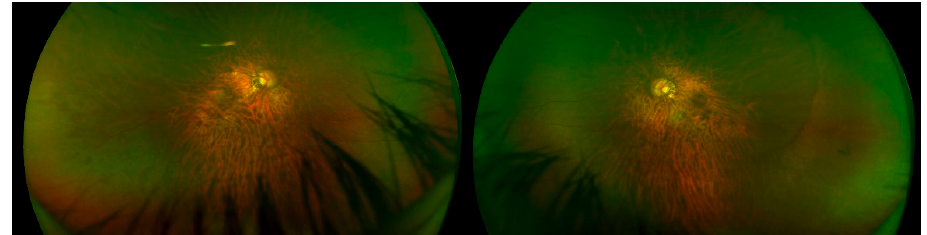
Figure 1. Posterior staphyloma. Right and left eyes. Optos (Marlborough, MA, USA).